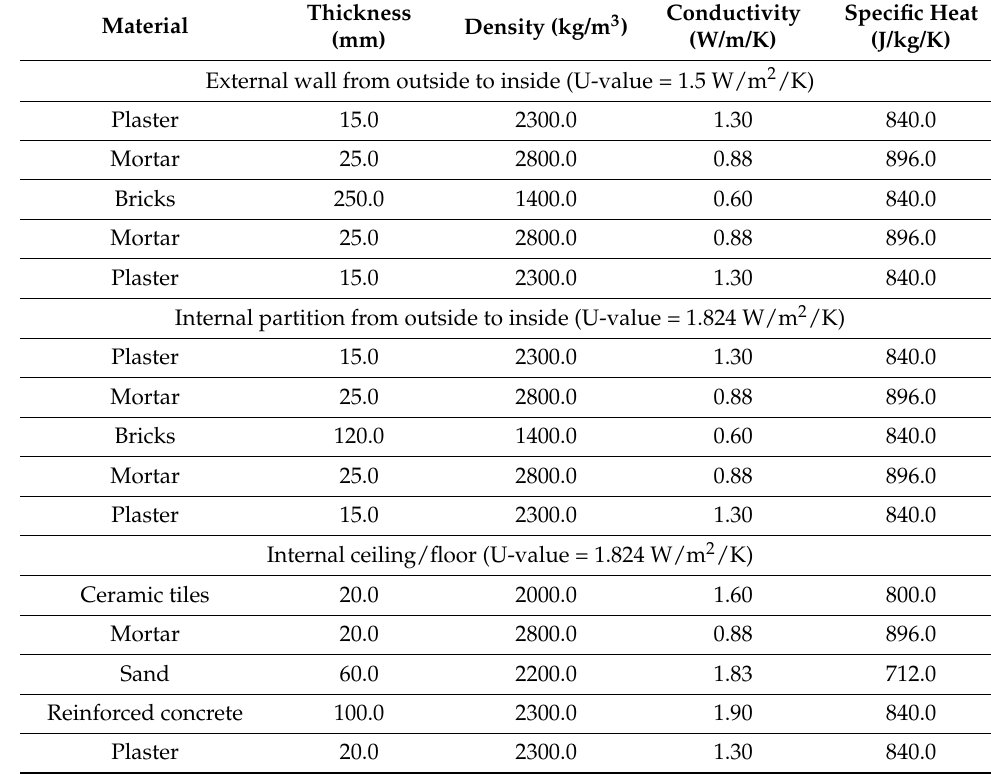
Table 1. Thermal properties of the opaque part of the envelope.